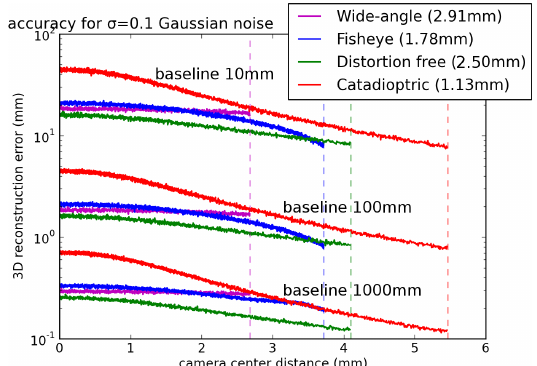
Figure 6: Different Baselines; This figure illustrates the effect of different baselines on 3D reconstruction. The graph shows the simulation for a σ = 0 . 1 pixel units. Plotted are the average reconstruction error values for each radius.